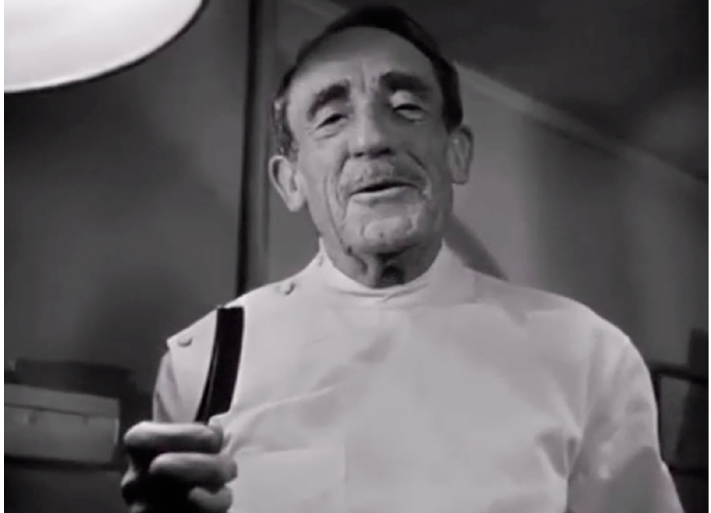
Figure 13. Image from Dark Passage (1947) [37].